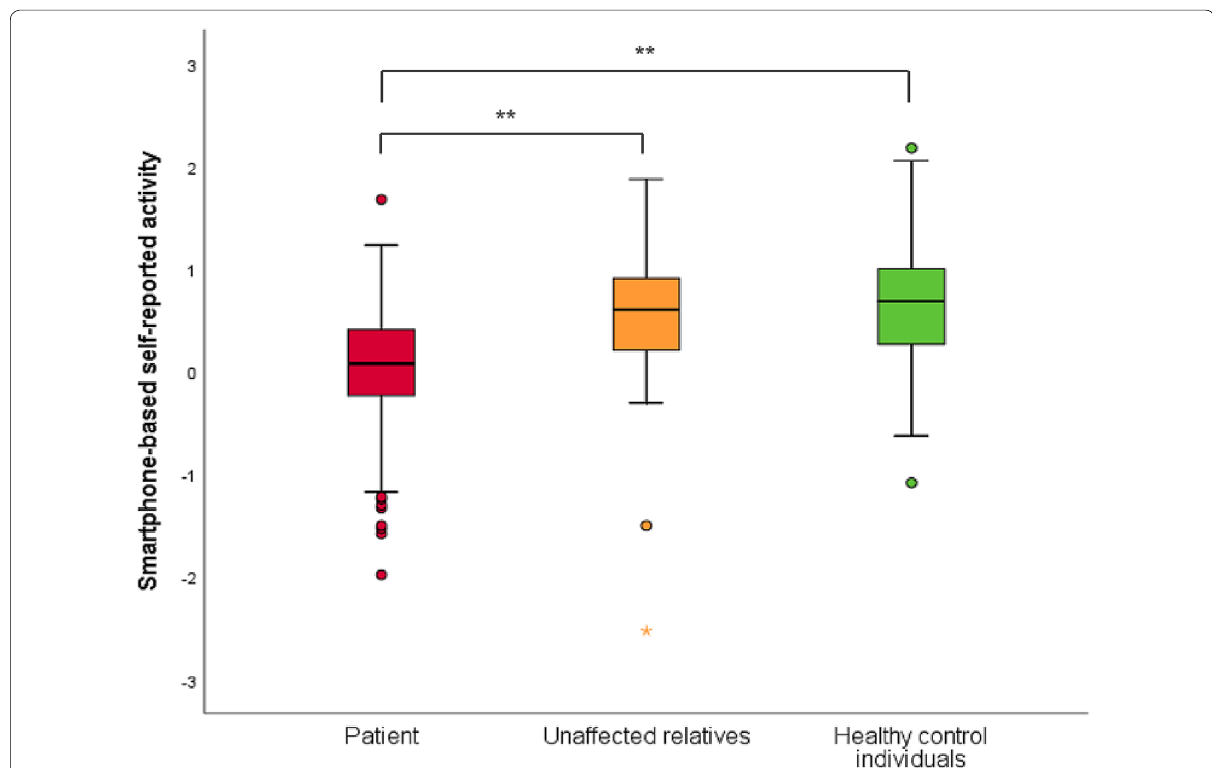
Fig. 1 Boxplots of smartphone‑based self‑reported activity in patients with newly diagnosed bipolar disorder, unaffected first‑degree relatives and healthy control individuals. The bottom and top of the box represent the first and third quartiles and the upper and lower whiskers extend from the box to the largest and lower value, respectively. No further than 1.5 times the interquartile range from the box. Data beyond the whiskers are plotted individually. ** p <